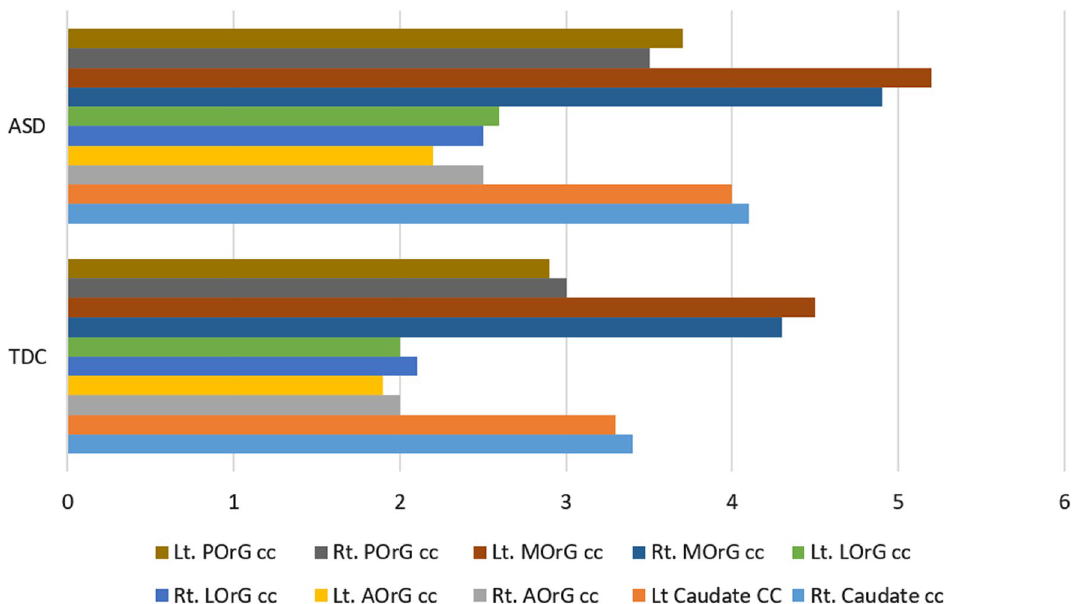
Fig. 5 Repetitive behavior brain components’ mean volume in TDC and ASD groups. POrG Posterior orbital gyrus, MOrG Medial orbital gyrus, LOrG Lateral orbital gyrus, AOrG Anterior orbital gyrus